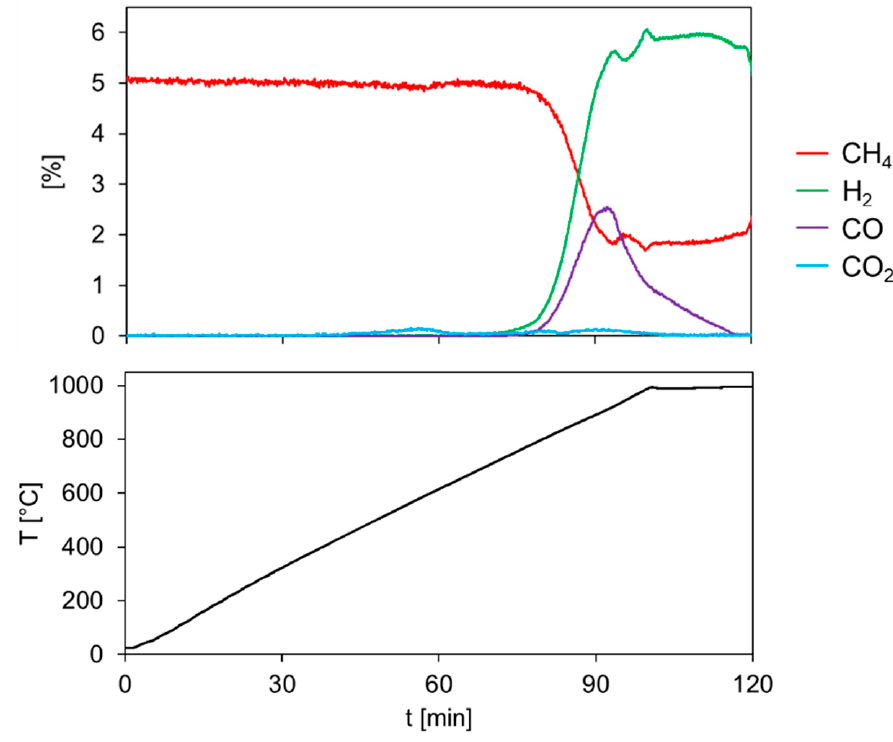
Figure 3. Temperature-Programmed Reduction with 5% CH 4 in fixed-bed conditions.